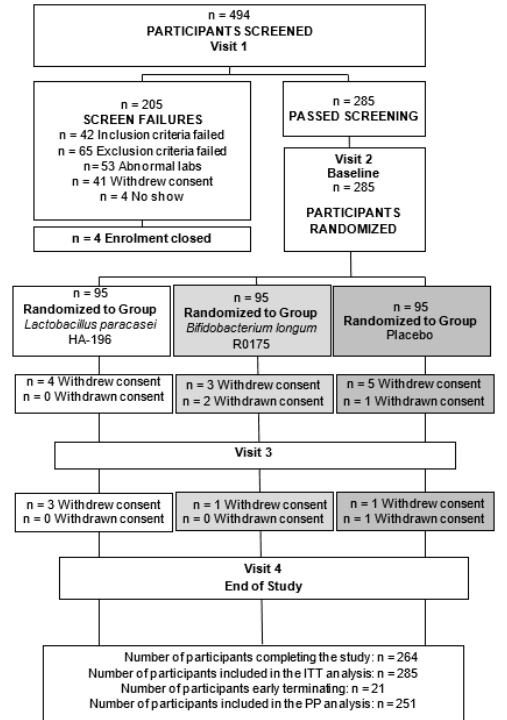
Figure 2. Participant disposition throughout the study. At the end of the study, 251 participants were included in the per protocol population. ITT, intent-to-treat; PP, per protocol.